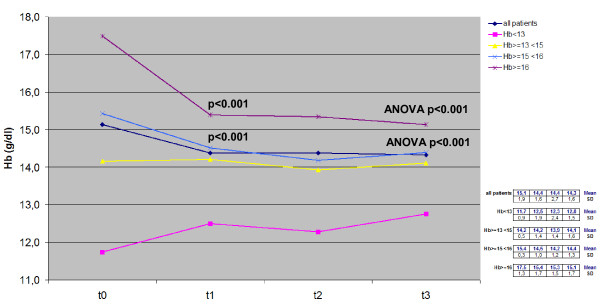
Time course of Hb values in the whole cohort and in each subgroup:ttest between t0and t1,and anova over time. Hb, haemoglobin.